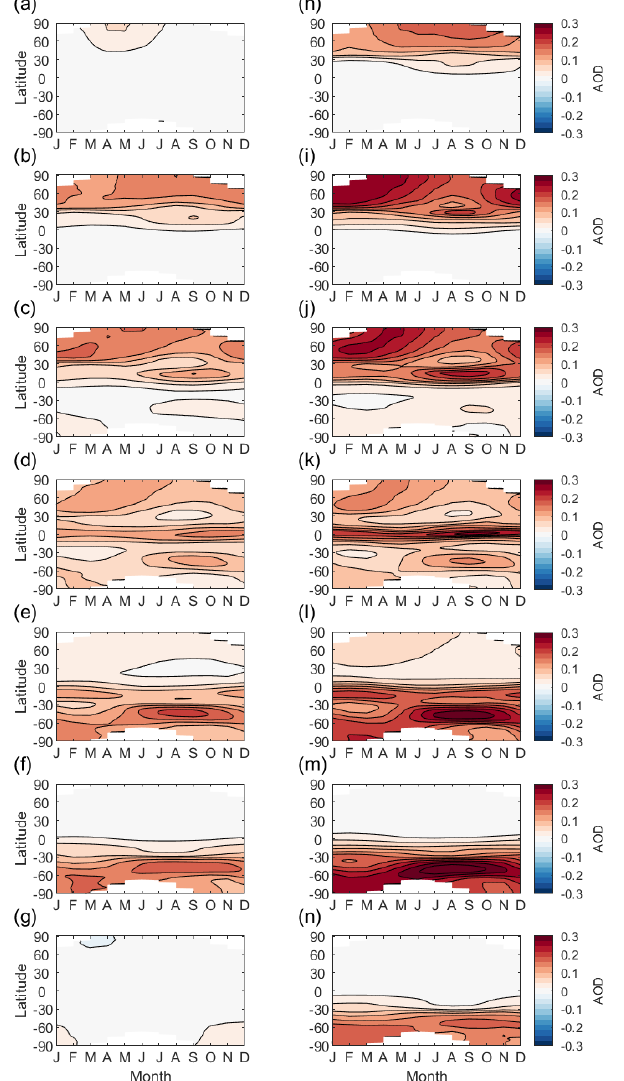
Figure 15. AOD patterns produced by low-altitude annually con- stant injection of 6Tgyr − 1 at (a) 50 ◦ N, (b) 30 ◦ N, (c) 15 ◦ N, (d) 0 ◦ , (e) 15 ◦ S, (f) 30 ◦ S, and (g) 50 ◦ S, and high-altitude annually constant injection of 6Tgyr − 1 at (h) 50 ◦ N, (i) 30 ◦ N, (j) 15 ◦ N, (k) 0 ◦ , (l) 15 ◦ S, (m) 30 ◦ S, and (n) 50 ◦